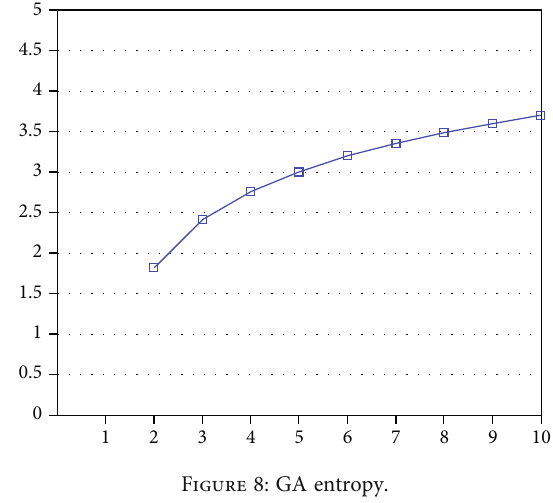
Figure 6: Randic ’ entropy for α = − 1/2 . Figure 8: GA